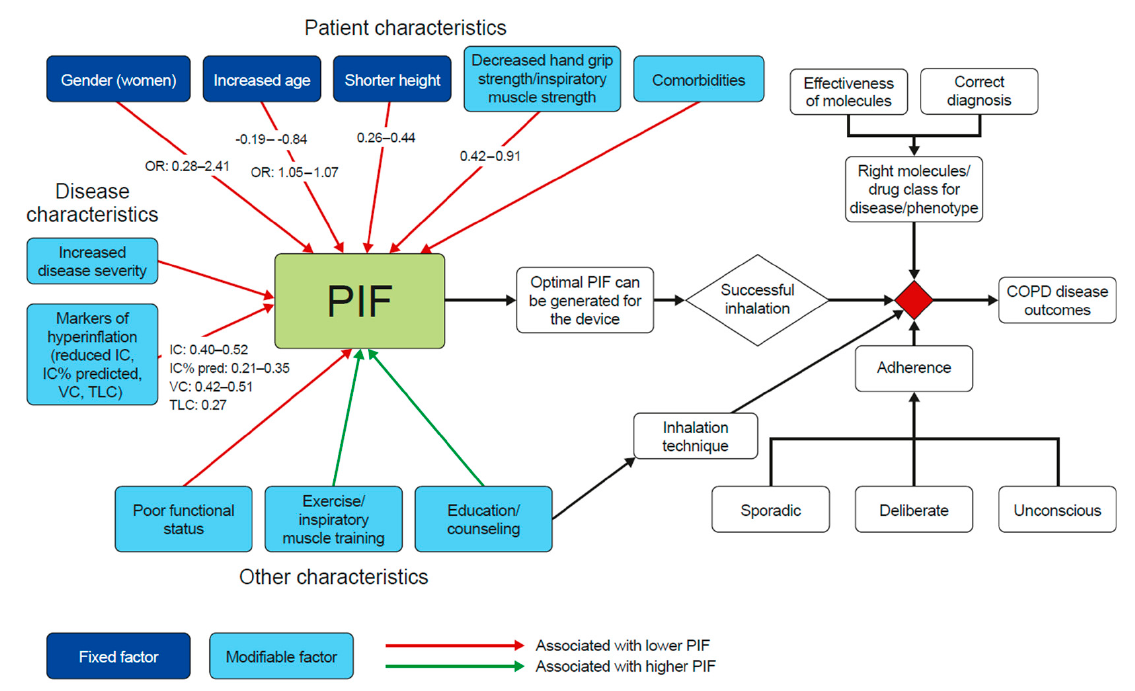
Figure 2. Impact of patient and disease factors on patient outcomes. Unless otherwise stated, data reported are R values; data only available for certain characteristics. Refer to Table 1 and the supplement for a full breakdown of the number of studies reporting correlation or risk estimates for each characteristic, as well as further detail on the nature of the statistical outputs calculated in each trial.